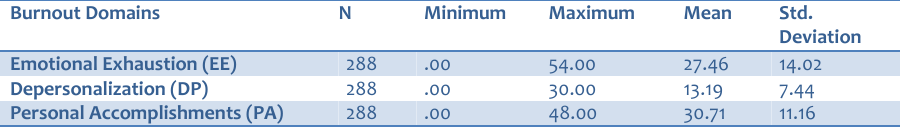
Table 2: Descriptive Statistics of the Experiences of Burnout among Sample Teachers Burnout Domains